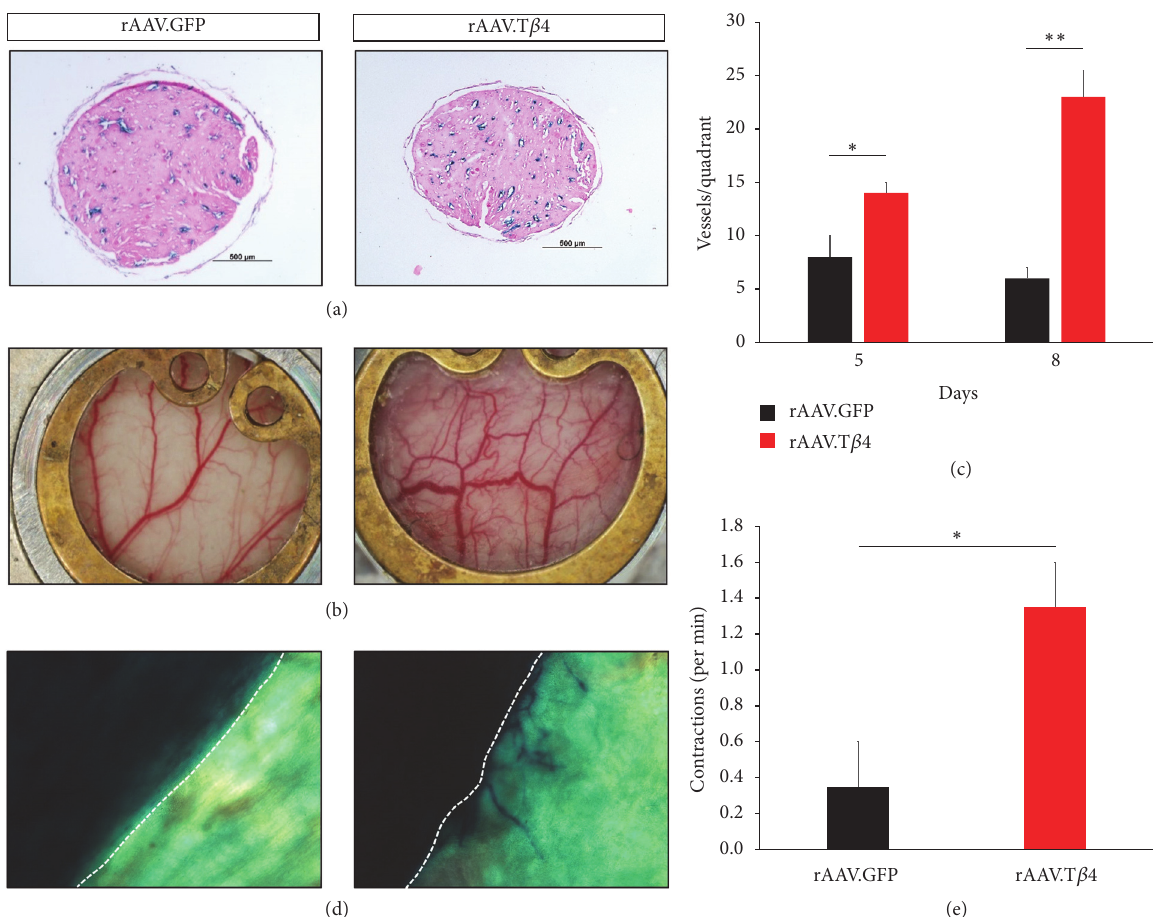
Figure 4: Increased vascularization and contractility in engineered heart tissue under Thymosin 𝛽 4 treatment. (a) Cross sections of EHTs from reporter mice expressing LacZ in endothelial cells (Cdh5-CreERT2 × Rosa26-LacZ) reveal an increase in capillary density if treated with T 𝛽 4. (b and c) AAV-mediated transfection with T 𝛽 4 (rAAV.T 𝛽 4, versus rAAV.GFP as control) of EHTs implanted into skinfold chambers leads to an increase of graft-vascularization, both 5 and 8 days after implantation ( 𝑛 = 4 per group, ∗ 𝑝 < 0.05 ; ∗∗ 𝑝 < 0.0008 ). (d) Images of whole skinfold chambers containing EHTs generated from LacZ reporter mice show little sprouting of graft resident endothelial cells into host tissue, while rAAV.T 𝛽 4 treatment drastically induces angiogenic sprouting into the host tissue of skinfold chambers (dotted lines indicate the graft/host border). (e) Treatment with rAAV.T 𝛽 4 leads to an increase of spontaneous contractions in implanted EHTs compared to rAAV.GFP control ( 𝑛 = 4 per group, ∗ 𝑝 < 0.05